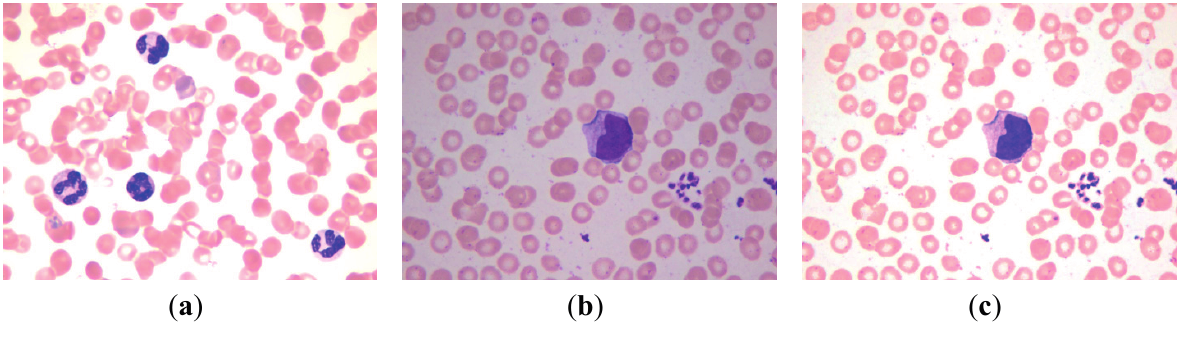
Figure 1. ( a ) Template image; ( b ) Input image; ( c ) Synthetic